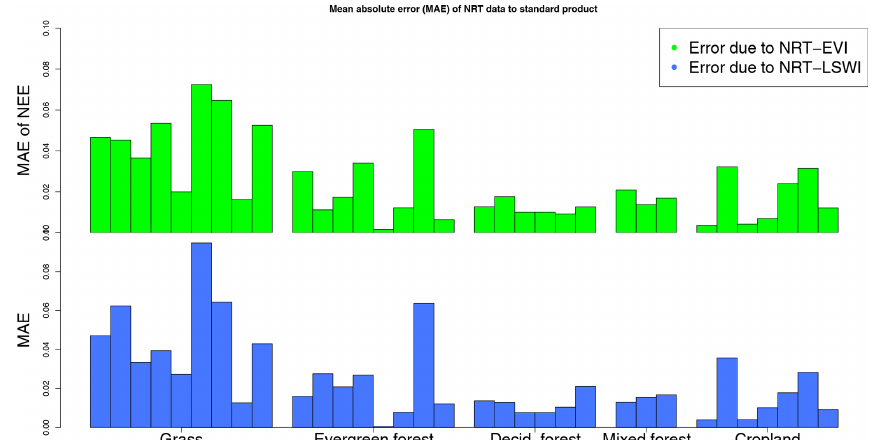
Figure 6. The normalized error of NEE as a result of MODIS NRT error at 33 sites. Overall, 120d from February to June in the year 2018 of MODIS NRT data are used to first calculate the EVI/LSWI differences, then multiplied by the sensitivities in Table 4 and normalized by the same scalar in the previous research. The flux sites in x axis are sorted by vegetation type and FLUXNET site ID (from left to right: CH-Cha, CH-Fru, CZ-wet, DE-Akm, DE-Gri, DE-RuR, DE-SfN, DE-Spw, IT-Tor, CH-Dav, DE-Obe, DE-Tha, FI-Hyy, FI-Sod, FR-Pue, IT-Cp2, IT-Lav, DK-Sor, FR-Fon, IT-CA1, IT-CA3, IT-Col, IT-Isp, BE-Bra, BE-Vie, CH-Lae, BE-Lon, CH-Oe2, DE-Geb, DE-Kli, DE-Rus, IT-BCi, IT-CA2). Table 4. The model’s sensitivity of NEE to EVI/LSWI for four seasons. The result of simulation (d) is used in the sensitivity calculation. Linear regression is applied to the change in EVI and the change in corresponding NEE, the maximum sensitivity appears in summer, with a slope of − 10 . 73 (µmolm − 2 s − 1 EVI − 1 ) for EVI and − 6 . 29 (µmolm − 2 s − 1 LSWI − 1 ) for LSWI, respectively. NEE sensitivity to EVI NEE sensitivity to LSWI Sensitivity Sensitivity (µmolm − 2 (µmolm − 2 Seasons s − 1 EVI − 1 ) R 2 Seasons s − 1 LSWI − 1 ) R 2 Dec–Feb − 0 . 90 0.27 Dec–Feb − 0 . 57 0.28 Mar–May − 7 . 96 0.64 Mar–May − 3 . 41 0.51 Jun–Aug − 9 . 11 0.74 Jun–Aug − 6 . 29 0.58